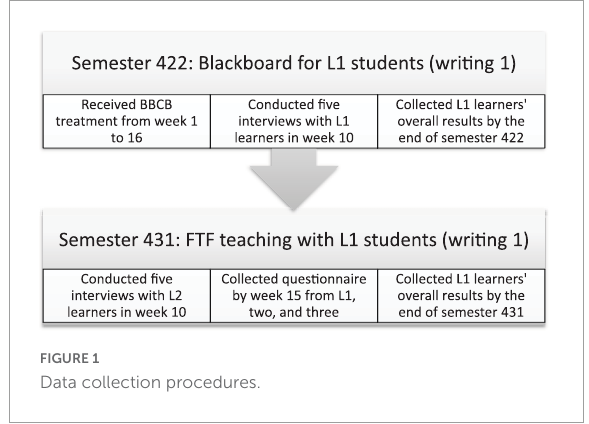
FIGURE1 Data collection